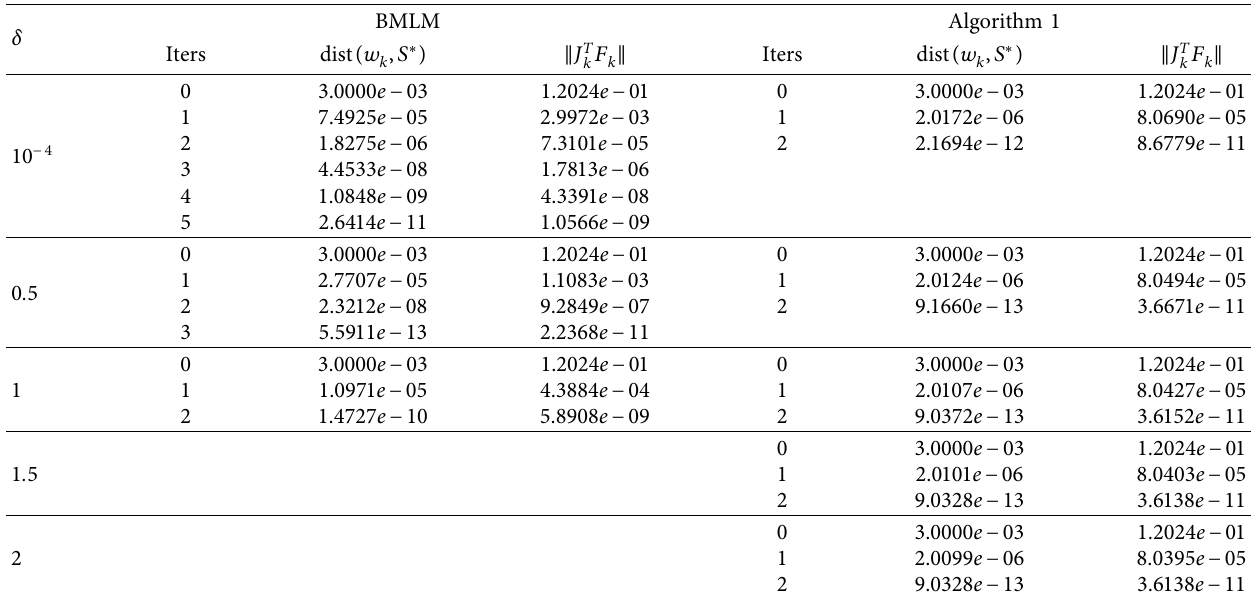
F ‖ < 10 − 8 and w k k